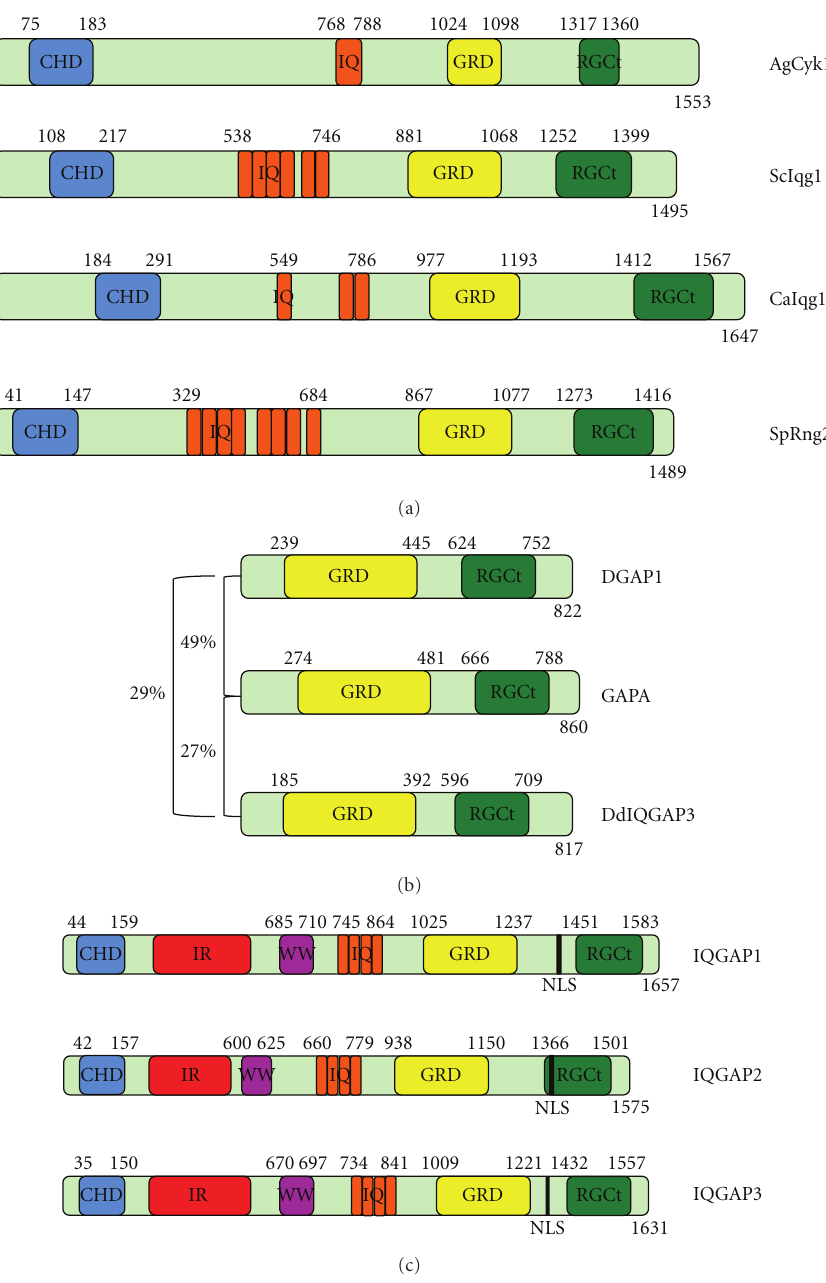
Figure 1: IQGAP domain structure in yeasts, Dictyostelium discoideum, and mammalian cells. Domain boundaries were determined by MotifScan using Prosite and Pfam sources [2]. (a) IQGAP family members from yeast. The most related members are AgCyk1 31% identical to ScIqg1, CaIqg1 20% identical to ScIqg1 and 24% identical to SpRng2. Note that additional IQ motifs were identified in CaIqg1 and ScIqg1 by visual scanning [3]. (b) IQGAP family members characterized in Dictyostelium discoideum . Percent identify at the amino acid level is shown for each pair. (c) Human IQGAP family members. CHD-calponin homology domain, IR-internal repeats (coiled-coil region), WW- tryptophan containing repeats, IQ-isoleucine and glutamine rich repeats, GRD-GAP-related domain, RGCt-Ras GAP C-terminus homology domain NLS, nuclear localization sequence. Note that not all members of the family contain each domain found in IQGAP1. Although